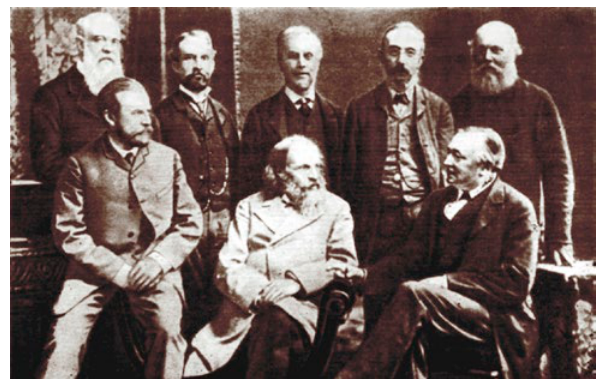
Figure 10. The participants of the 52 nd meeting of British Asso- ciation for the Advancement of Science, Manchester, 1887. 1 st rank (from left to the right): Menshutkin N.A., Mendeleev D.I., Roscoe H.E.; 2 nd rank: outside left - Joule J.P., president of Association, Shorlemmer C. (second from the right side), Thompson W., outside right (permission of Museum and archives of Dmitri Mendeleev in St,